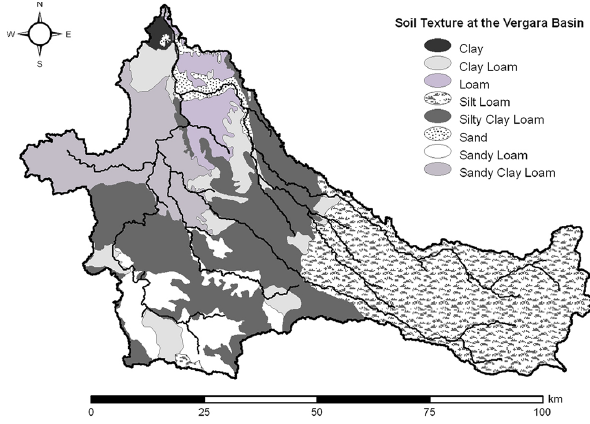
Fig. 2. Soil types in the Vergara